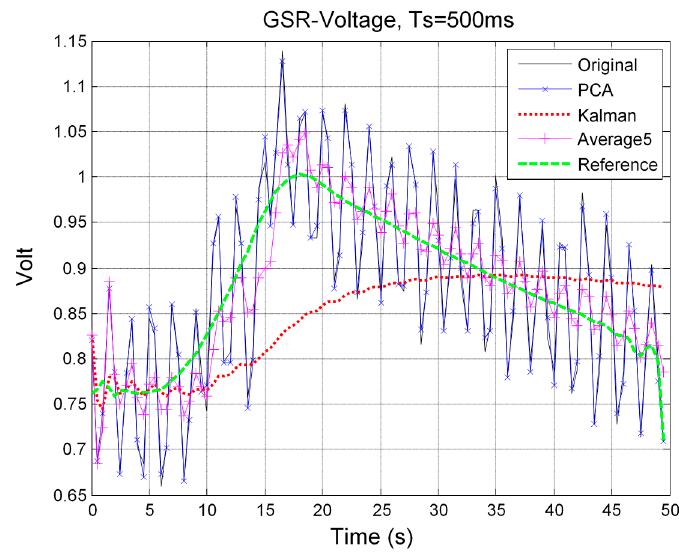
Figure 9. Skin Conductance Voltage Measurement with sampling period 500 ms.